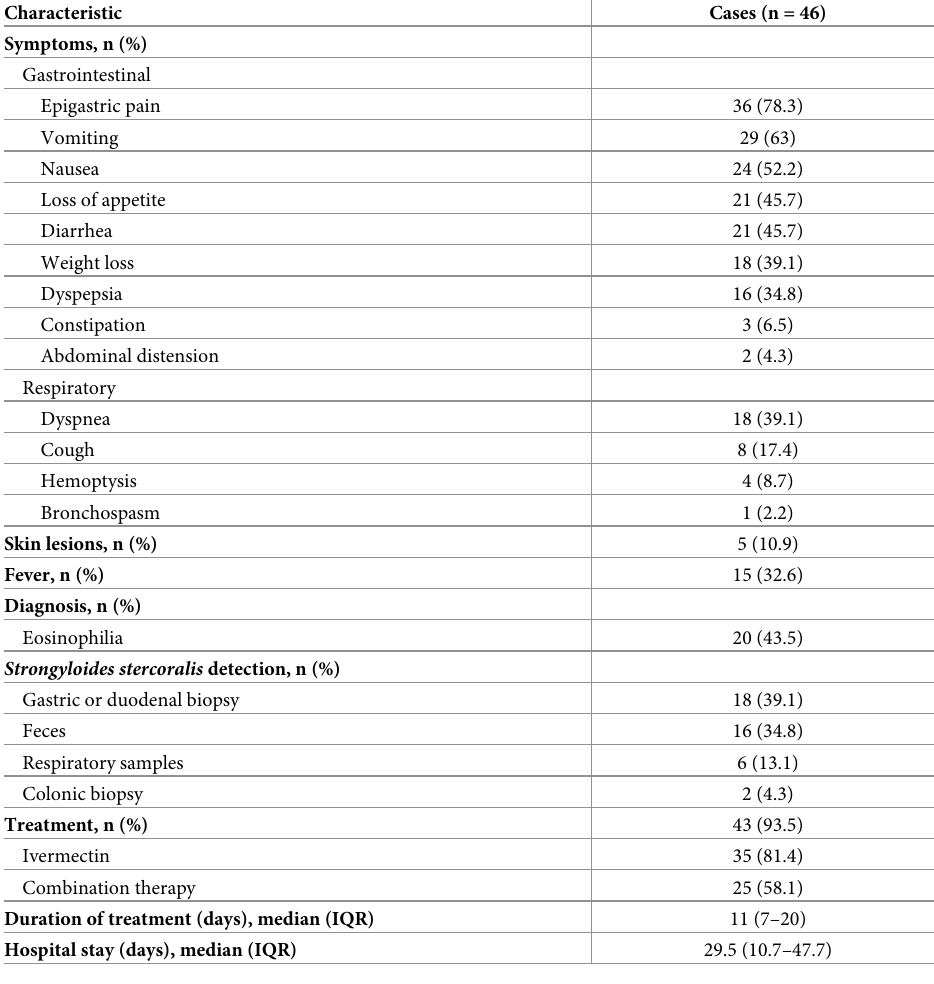
Table 1. Clinical and biochemical data related to 46 kidney transplant recipients with severe Strongyloides stercor- alis